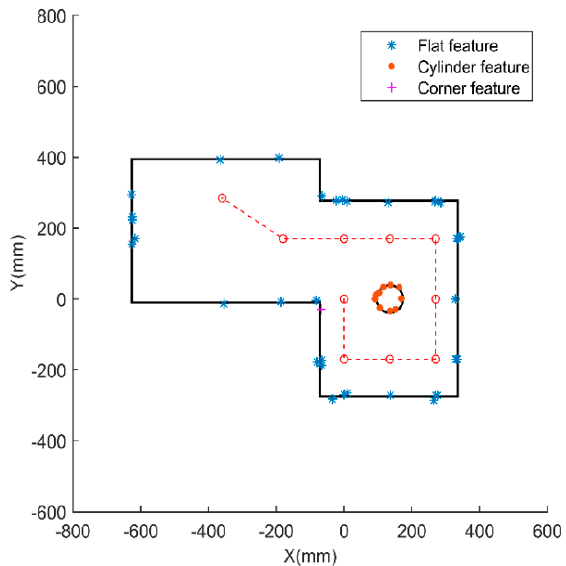
Figure 12. Feature classification by fuzzy model.